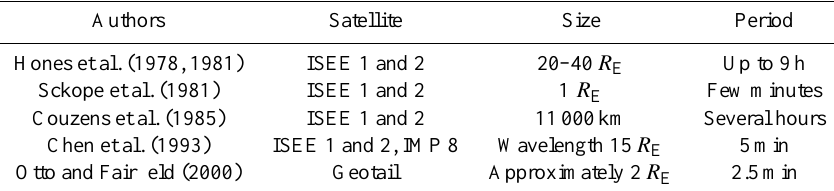
Fig. 12. Vortex progression of 30 March from 02:46 to 02:49UT from Collado-Vega et al. (2007). Within only 4min the vortex core travels approximately 12 R E down the flank. The velocity of rotation increases significantly along the flank, from 20 to 60kms − 1 , while its traveling velocity decreases when the vortex becomes fully ordered around 02:48UT. This is not typical of the vortices found in the present study. Table 4. Previous